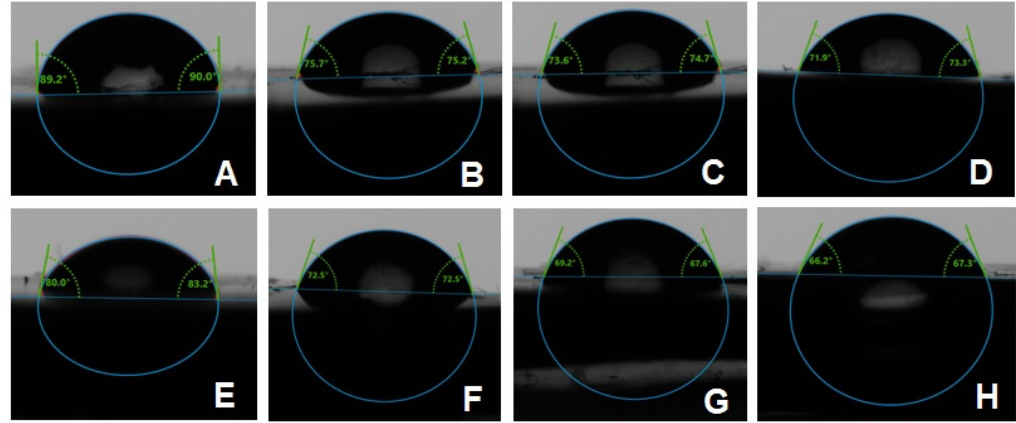
Figure 9. Representative contact angle images of CP groups: ( A ) unmodified, ( B ) 0.1% ND, ( C ) 0.25% ND, ( D ) 0.5% ND; and AP groups: ( E ) unmodified, ( F ) 0.1% ND, ( G ) 0.25% ND, ( H ) 0.5% ND.